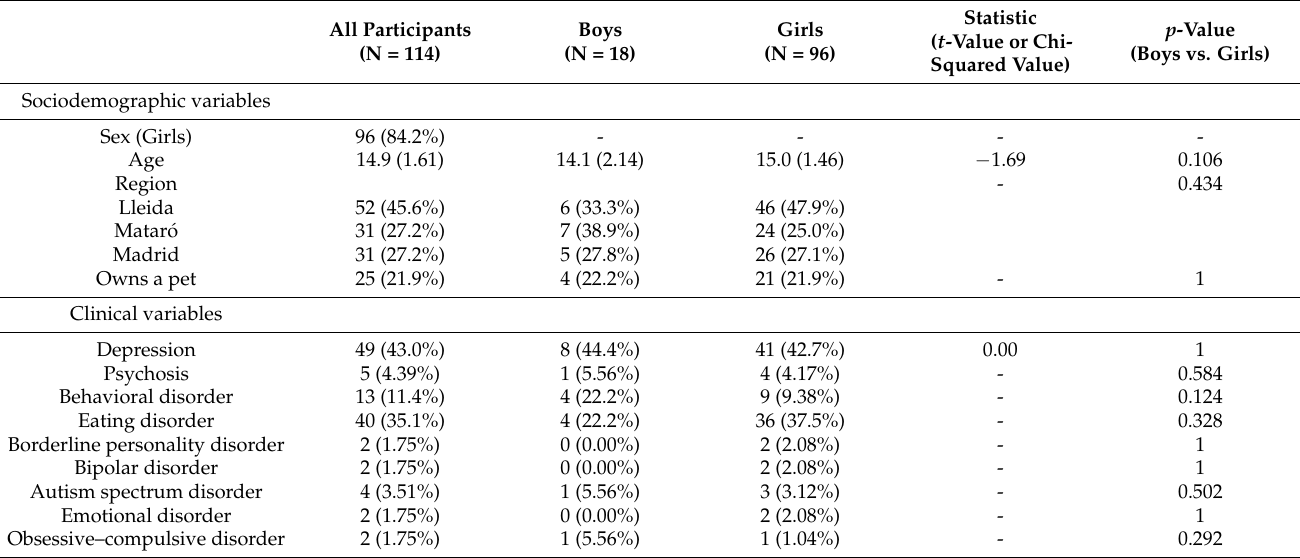
Table 1. Description of the sample.